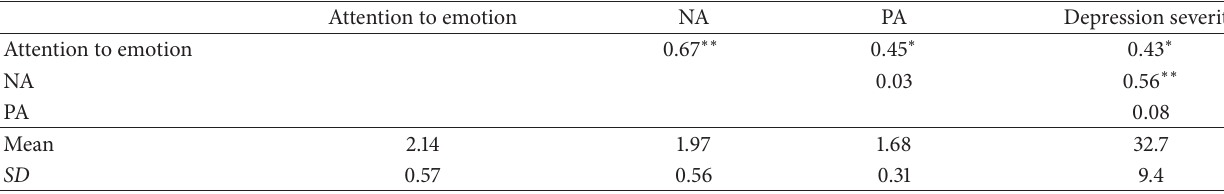
Table 1: Means and correlations of constructs of interest. Attention to